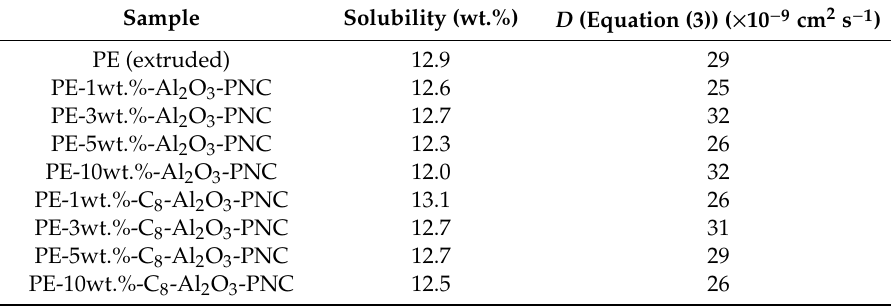
Figure 3. Desorption solubility (21 °C) as function of particle wt.%. ( a ) Acetophenone, ( b ) limonene. The standard deviation was 0.02 wt.% for acetophenone and 0.10 wt.% for limonene, based on 5 replicates per solute for each filler fraction. Table 3. Solubility and diffusivity. Limonene desorption data at 21 °C.